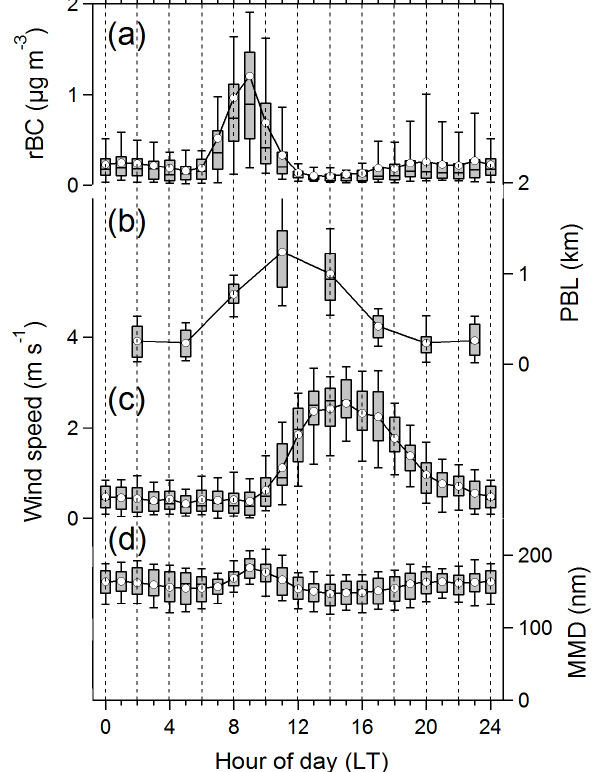
Figure 3. Diurnal variations of (a) refractory black carbon (rBC) mass concentrations, (b) planetary boundary layer (PBL) heights, (c) wind speeds, and (d) mass median diameters of the rBC parti- cles (MMD). The lower and upper edges of the boxes denote the 25 and 75% percentiles, respectively. The short black lines and white circles inside the boxes indicate the median and mean val- ues, and the vertical bars (“whiskers”) show the 10th and 90th per- centiles. LT stands for local